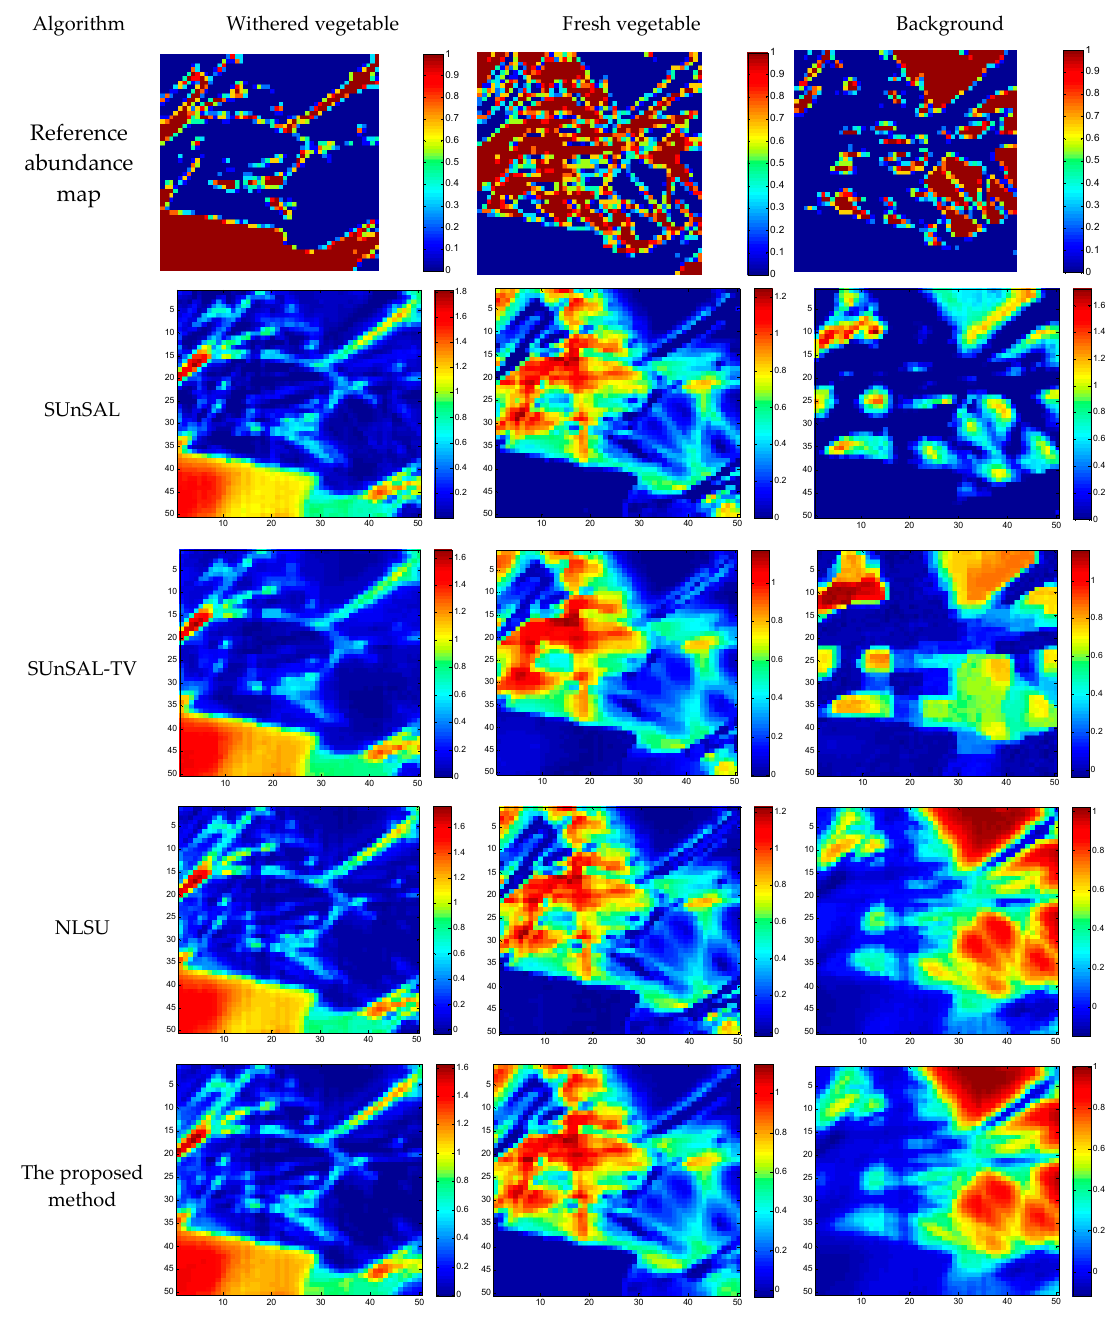
Figure 11. Estimated abundances of the three components for R-1.